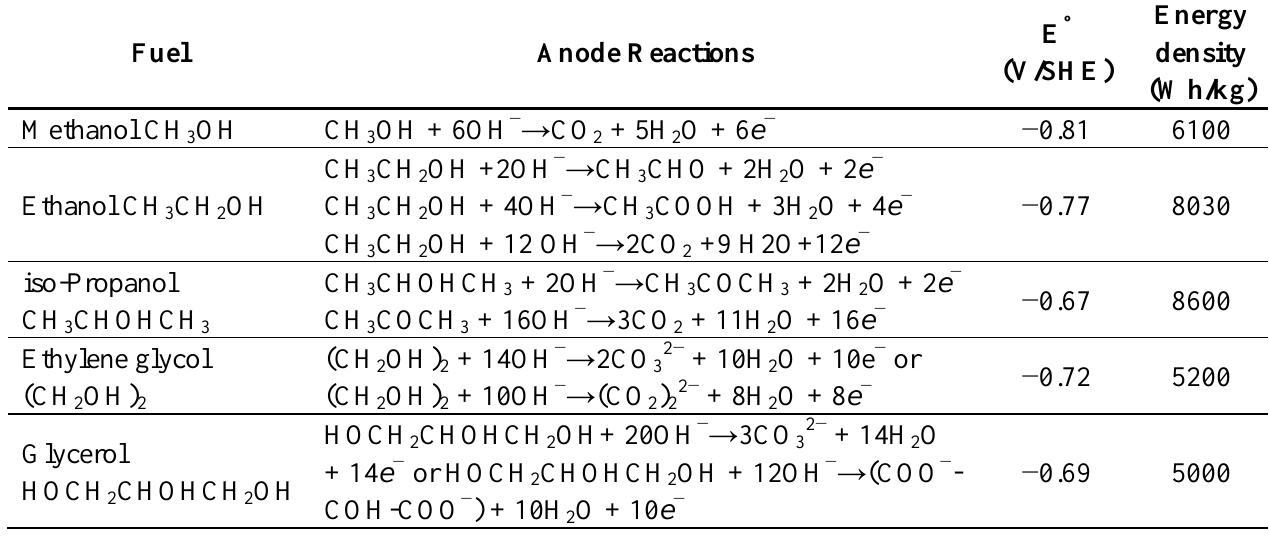
Table 1. Electrochemical oxidation of various alcohols in alkaline